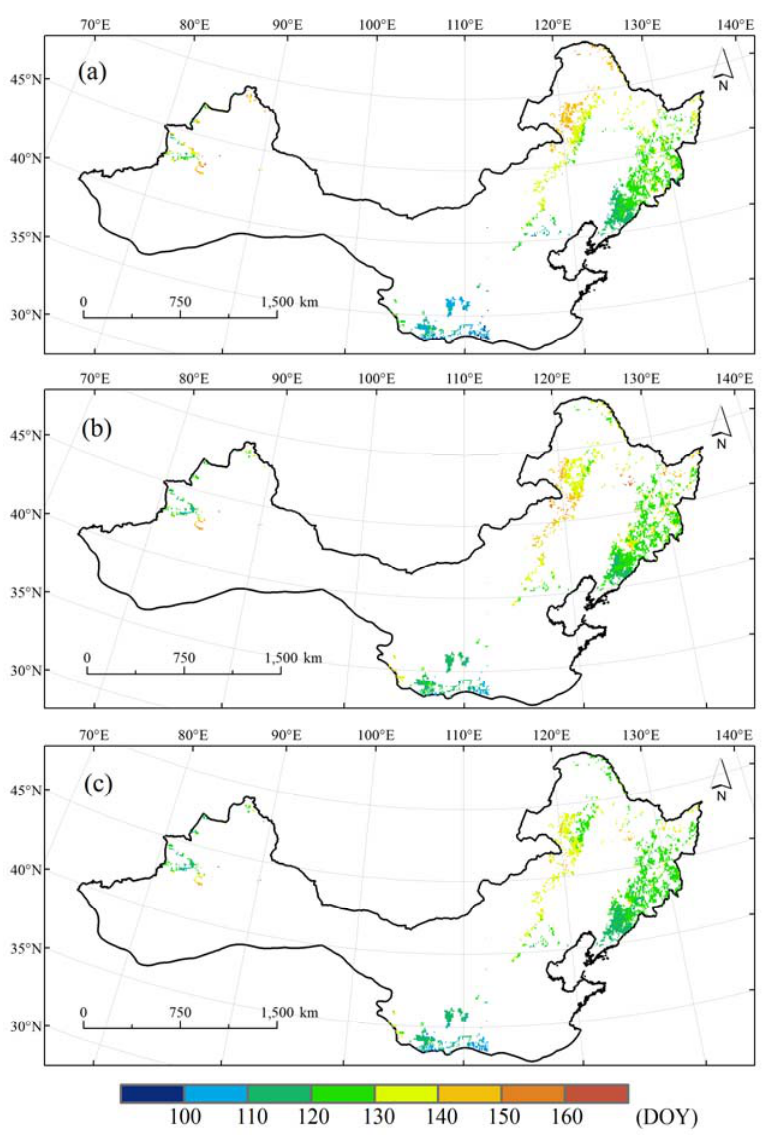
Figure 4. Spatial pattern of mean BGS (growing season beginning), SOS (start of season) and SOS3g over 1986 to 2006 in the deciduous broadleaf forest of northern China. ( a ) BGS; ( b ) SOS; ( c )